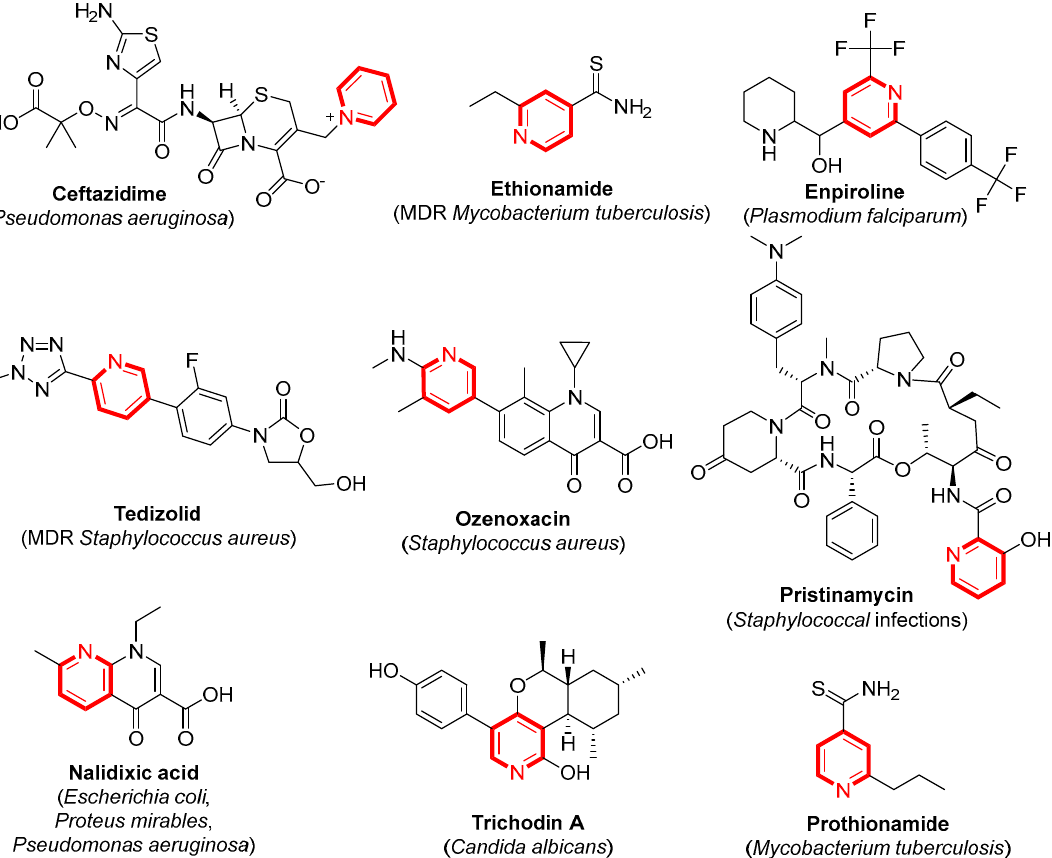
Figure 1. FDA approved drugs containing pyridine scaffold to treat bacterial and fungal infections. The pyridine ring offers favorable intermolecular interactions with drug targets through π - π stacking, hydrogen bonding, and metal coordination, and it is a